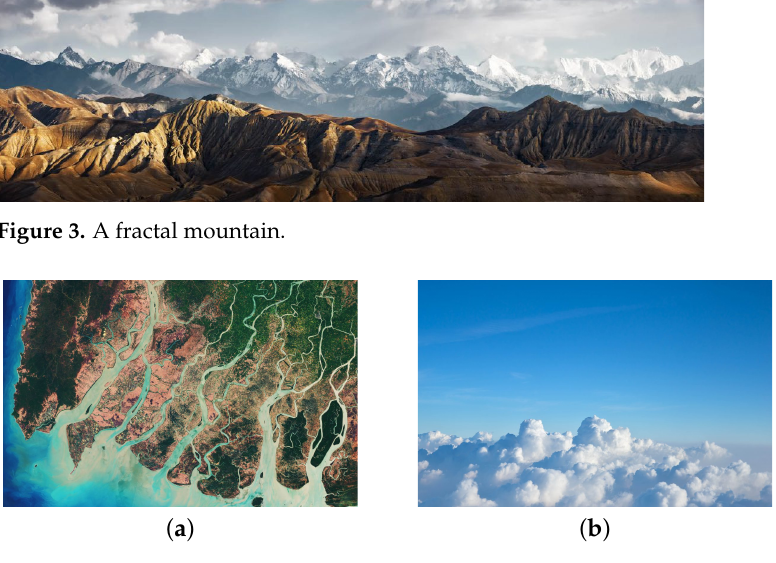
Figure 4. ( a ) A fractal river detla, ( b ) a fractal sky